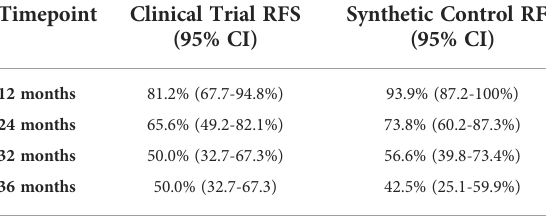
TABLE 3 Recurrence-free survival